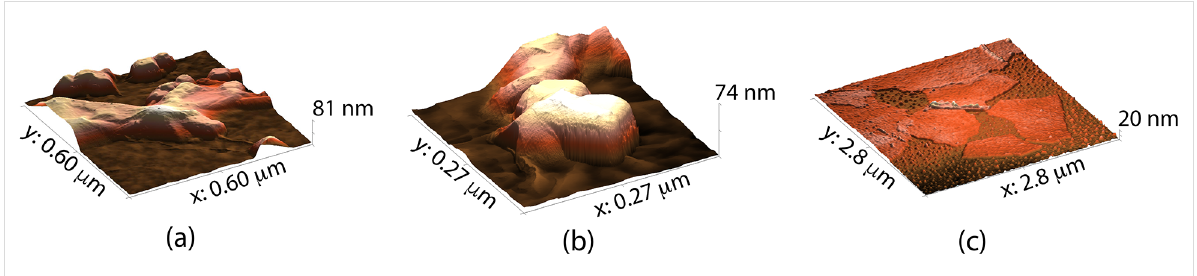
Figure 5: (a) AFM image of GO-covered silver nanocubes obtained from Langmuir–Blodgett transfer at 15 mN/m. (b) AFM image of GO-covered silver nanocubes obtained from direct sequential adsorption. (c) AFM image of the GO flakes on silicon oxide surfaces.